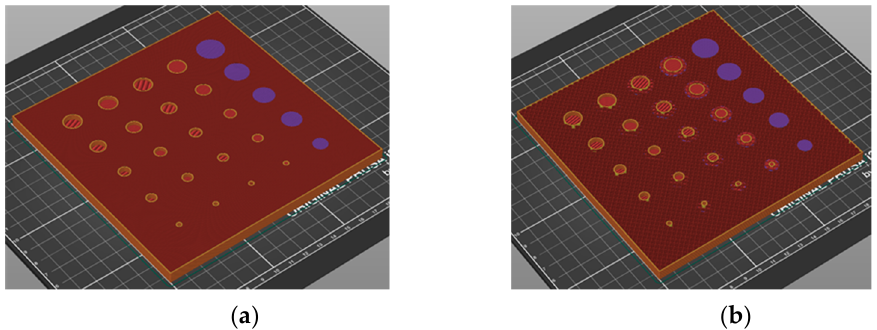
Figure 2. Visualization of the printing process for chosen layer (screenshot from the PrusaSlicer). ( a ) sample S1 with 100% infill, ( b ) sample S2 with 30% infill.